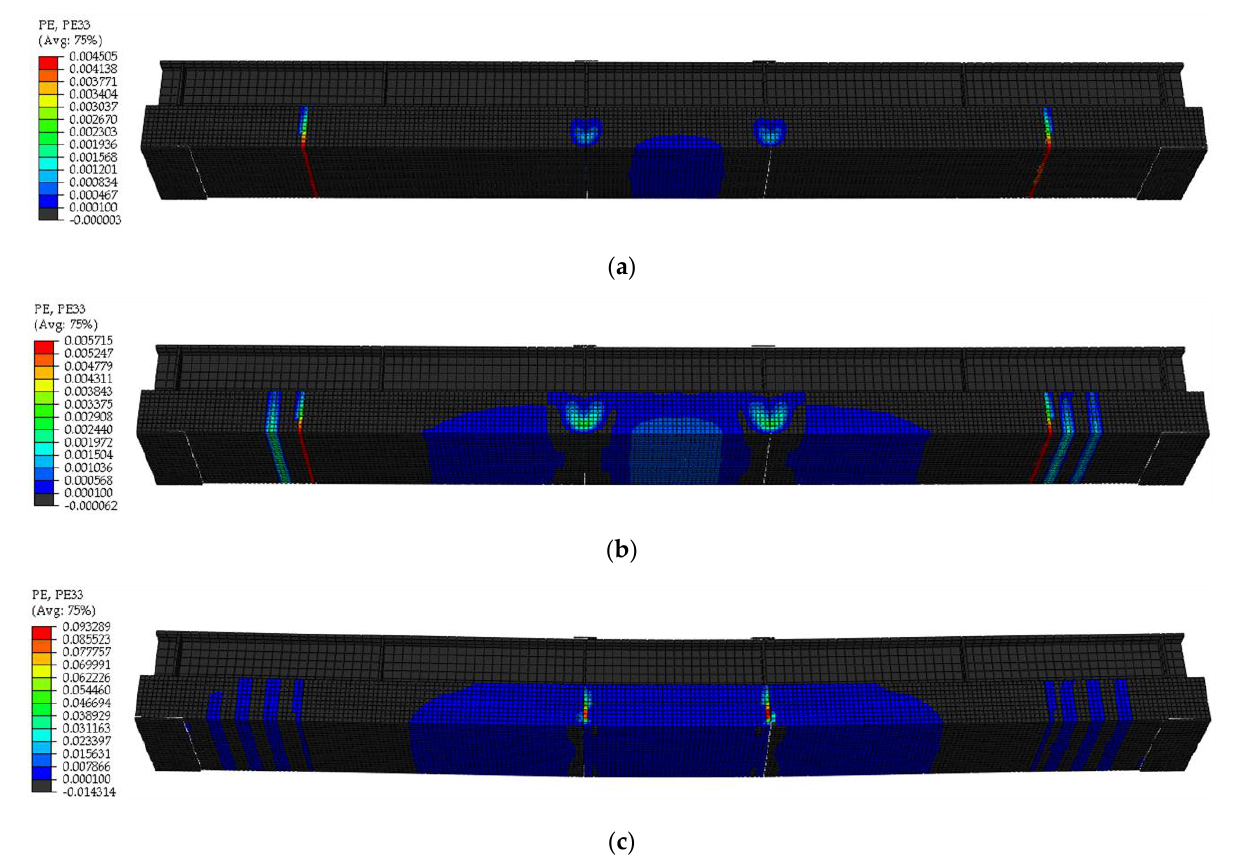
Figure 14. Crack development for a UHPC layer ratio of 1.0: ( a ) applied load equals 225 kN; ( b ) applied load equals 400 kN; ( c ) applied load equals 425 kN.